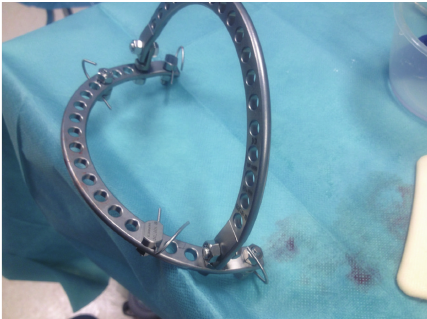
Figure 4: Perpendicular arrangement of Ilizarov